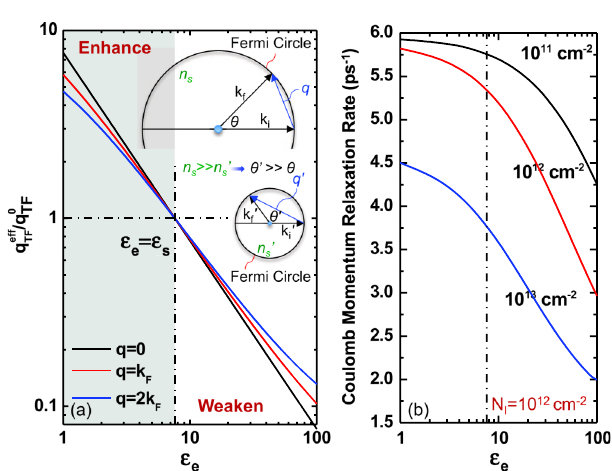
FIG. 2. Effect of dielectric mismatch on the (a) free-carrier screening and (b) Coulomb momentum relaxation rate at zero temperature. The inset of (a) shows schematically the scattering angle for different electron